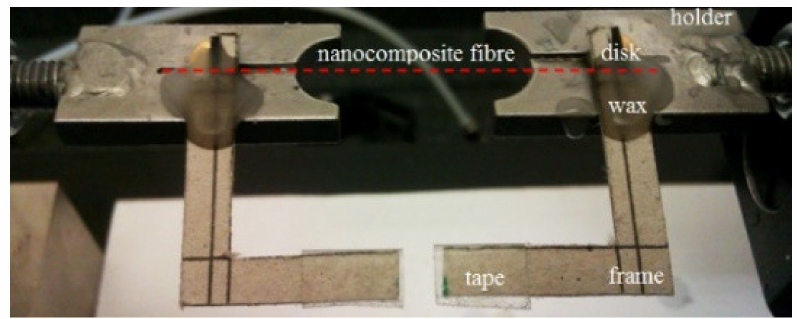
Figure 2. Frame with fixed fibers on the machine’s